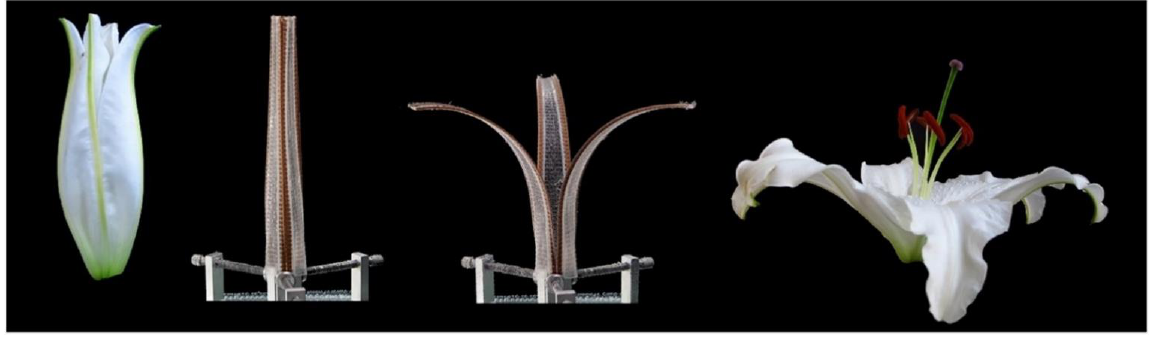
Figure 10. Edge growth causing a strain gradient in the Lilium ‘ Casa Blanca ’ drives the flower opening mechanism, a principle that is translated into a 4D printed mechanism with a wood-based hygromorph composite edge. Adapted from Poppinga et al. [176] with copyright permission of Oxford University Press.